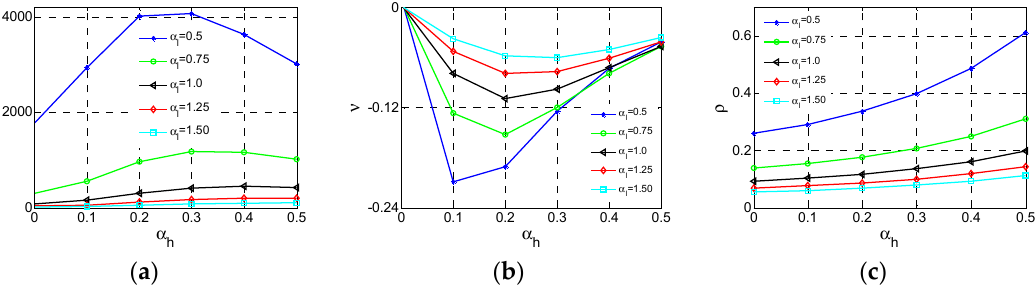
Figure 9. The changes of the effective properties with respect to the height ratio α h and the length ratio α l for Type B cell: ( a ) effective Young’s modulus E ; ( b ) effective Poisson ratio v ; ( c ) relative density ρ .